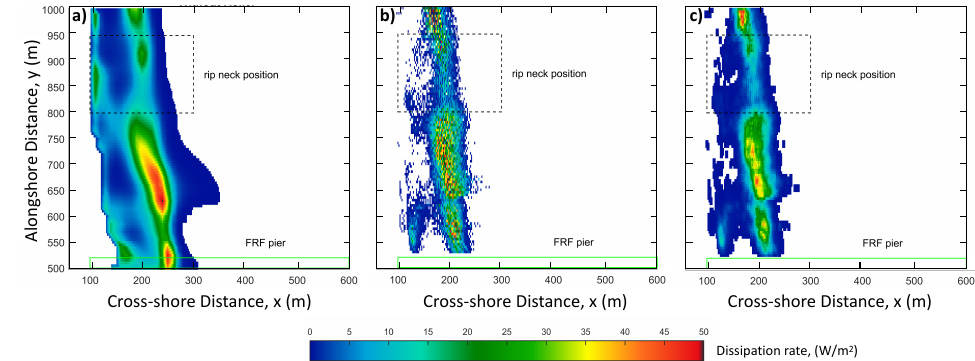
Figure 8. ( a ) ROMS model output of the average dissipation rate, over a 30 min period; ( b ) Observed average dissipation rate over the entire R2 (15 min); ( c ) Spatial average of data in panel ( b